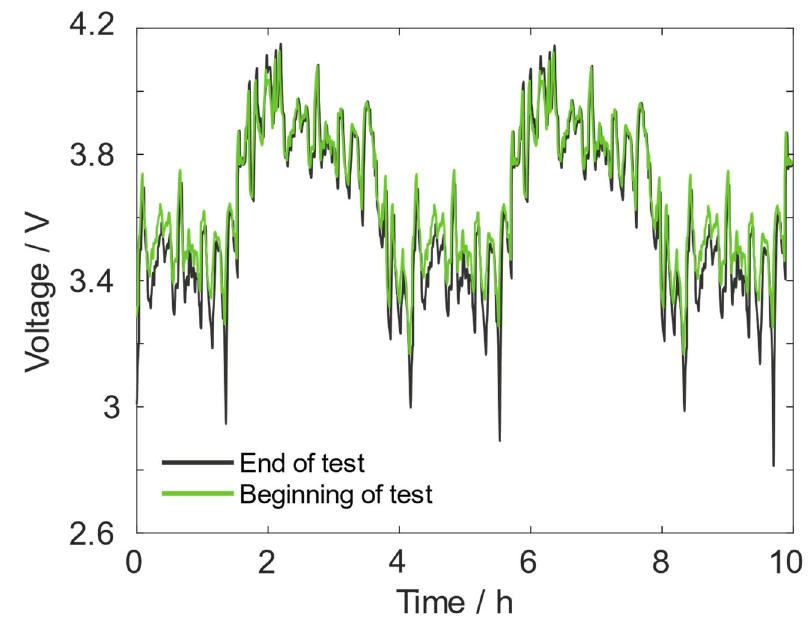
Figure 4. Ba tt ery voltage response to the FRPS cycle at BOL and after 870 equivalent full cycles. Figure 4. Battery voltage response to the FRPS cycle at BOL and after 870 equivalent full